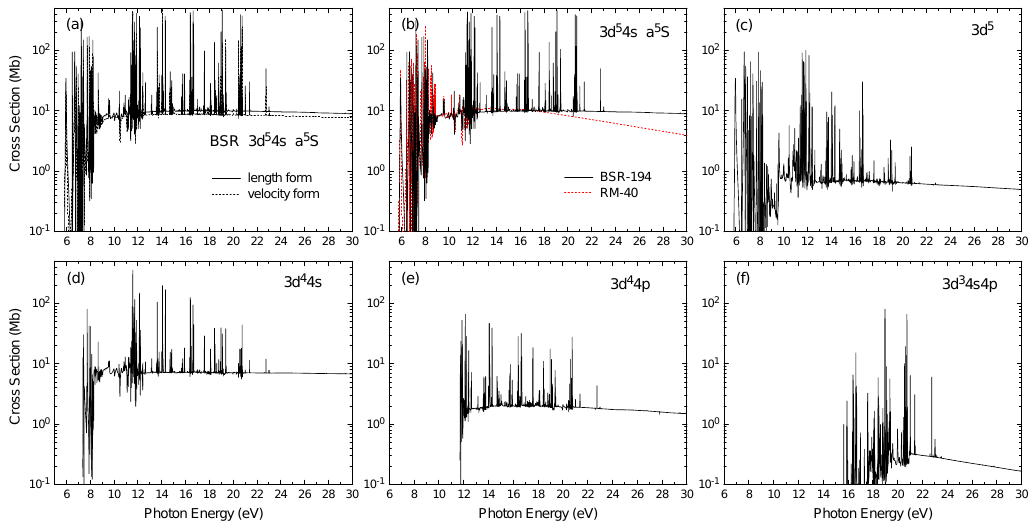
Figure 2. Total and partial photoionization cross sections from the excited 3 d 4 4 s 5 S state of Cr I as a function of photon energy. Panel ( a ) shows total cross sections from the present BSR-194 model in the length and velocity forms. Panel ( b ) compares the BSR-194 model with the RM-40 calculation of Nahar [14]. Panels ( c – f ) show summed partial cross sections for leaving the residual Cr II ion in final states of the 3 d 5 , 3 d 4 4 s , 3 d 4 4 p , and 3 d 3 4 s 4 p configurations,